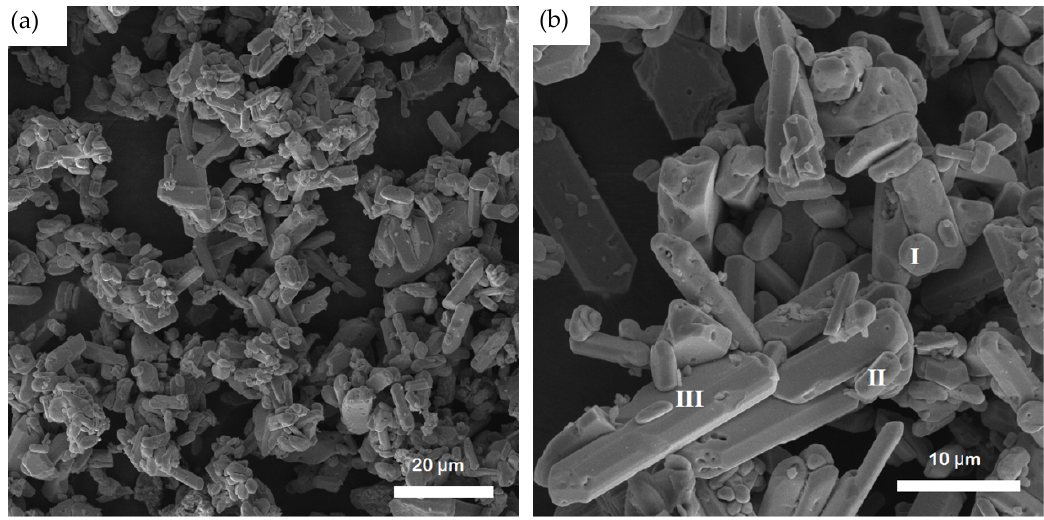
Figure 6. ( a ) Low and ( b ) high magnification SEM images of MoAlB particles resulting from 6 h of firing at 1000 °C and the subsequent acid leaching.